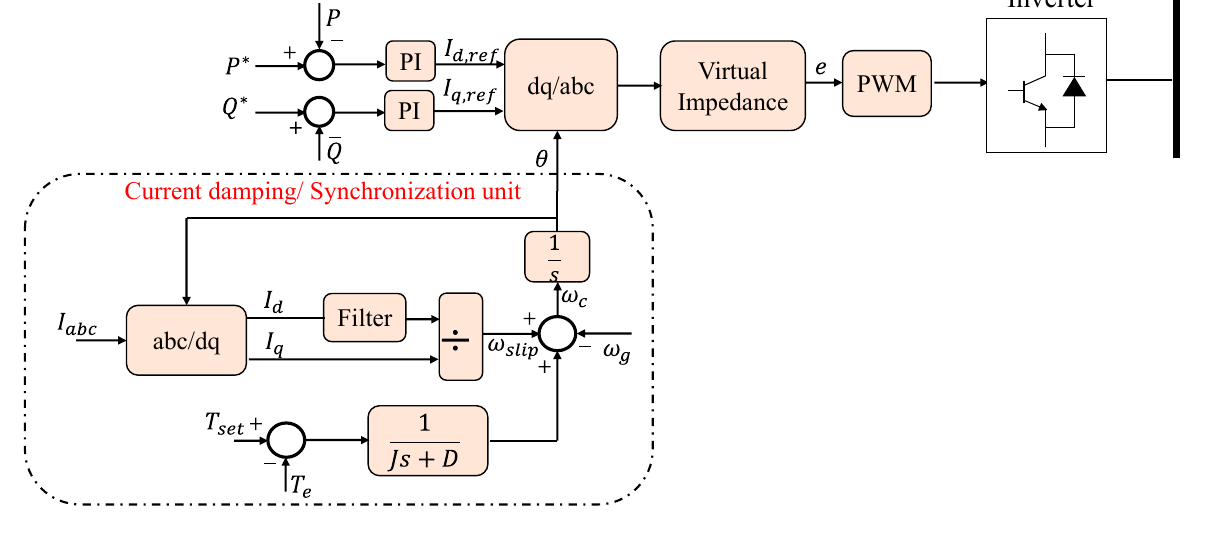
Figure 12. Inducverter control diagram [6,38].